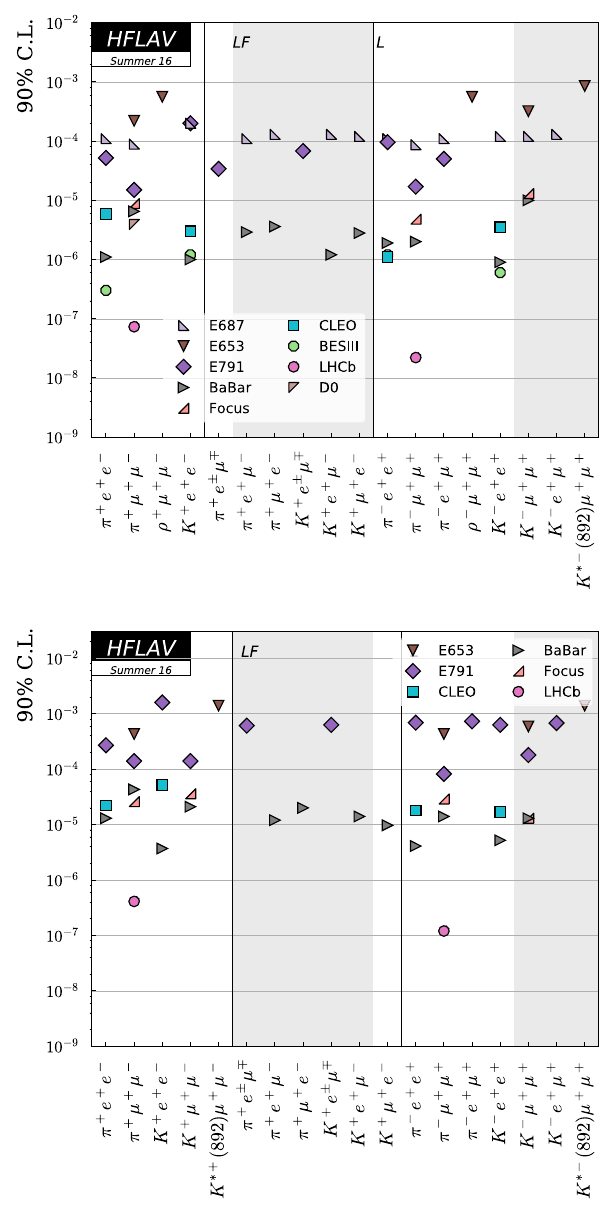
Fig. 218 Upper limits at 90% C.L. for D + ( top ) and D + s ( bottom ) decays. Eachplot showsflavor-changing neutralcurrentdecays,lepton- flavor-changing decays (LF), and lepton-number-changing (L) decays